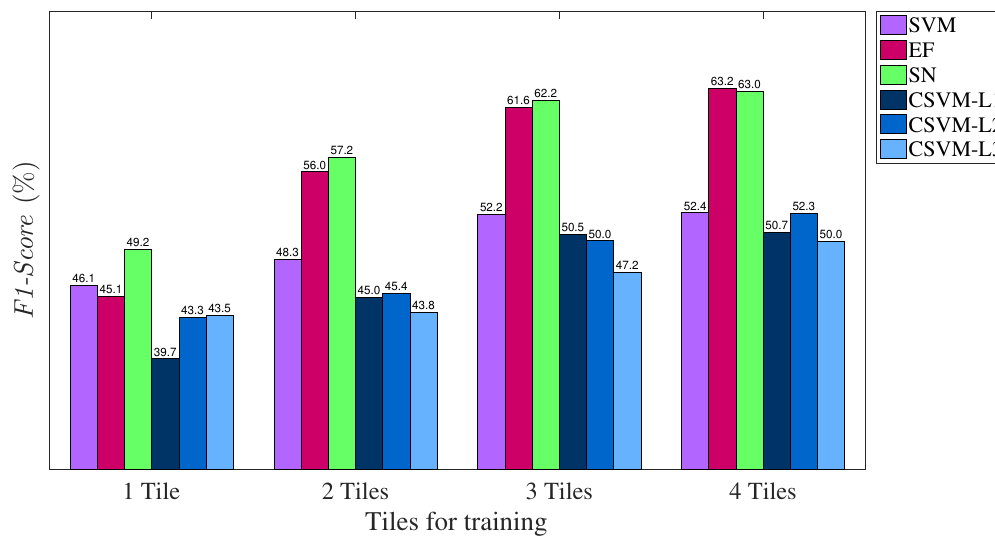
Figure 9. F1-score of Amazon Biome obtained from SVM, EF, SN, and CSVM (after each layer) using one, two, three, and four tiles for training.